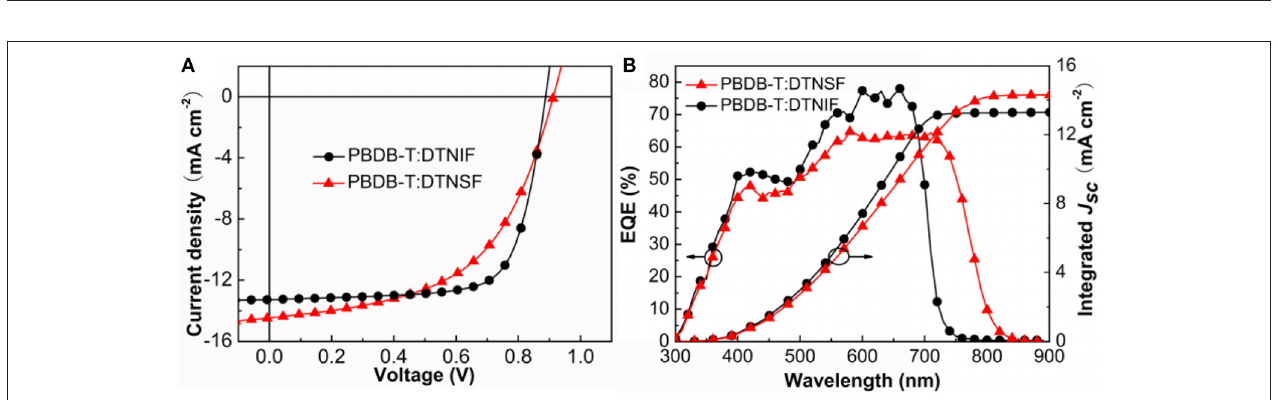
FIGURE 5 | (A) J – V characteristics of the non-fullerene OSCs. (B) EQE and the corresponding integrated J sc curves for the OSCs.